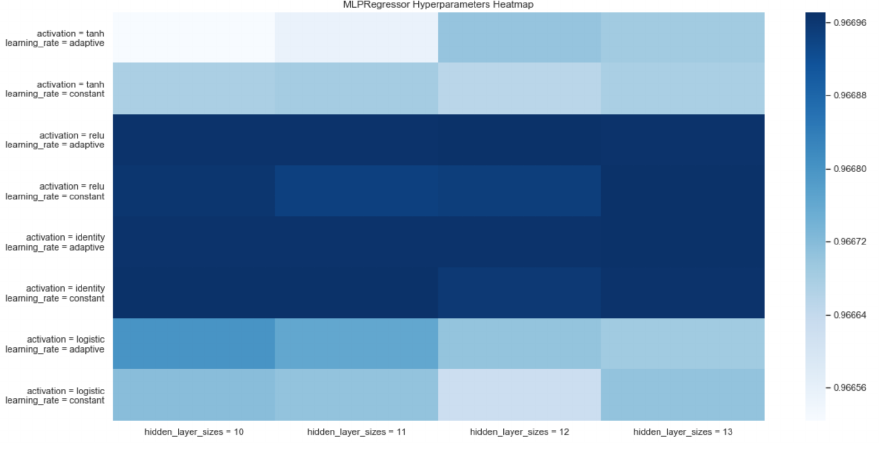
Figure 9. MLPRegressor Hyperparameter Heat Map.